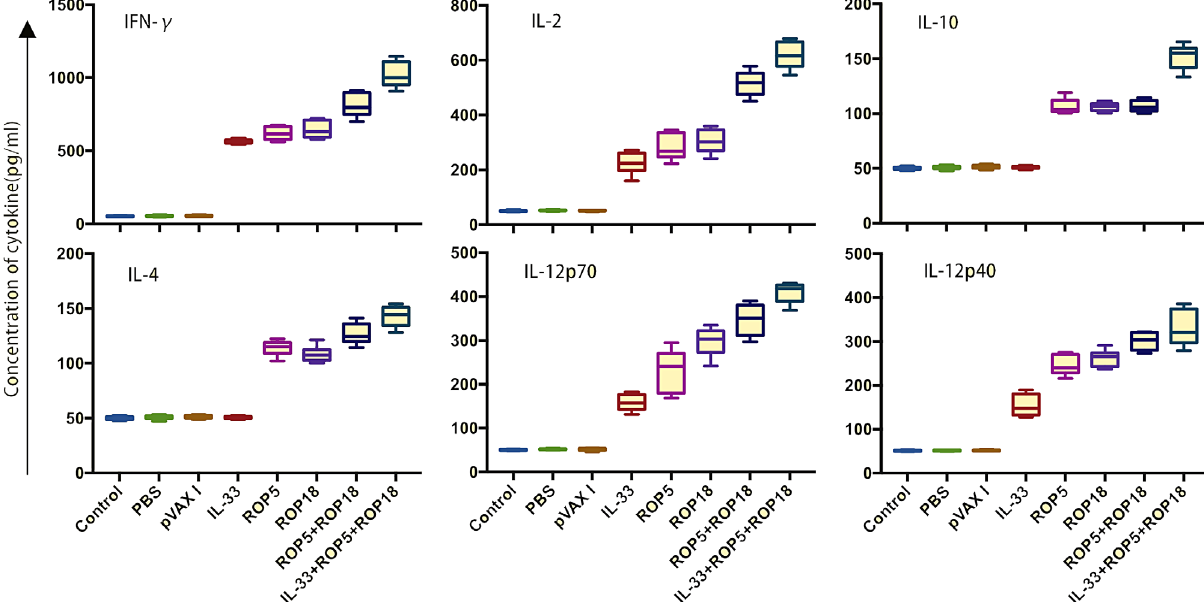
Figure 3. Cytokine production by splenocytes of immunized Kunming mice after stimulation by toxoplasma lysate antigen (TLA). Each bar represents mean pg/mL (±SE, n = 3). * p <